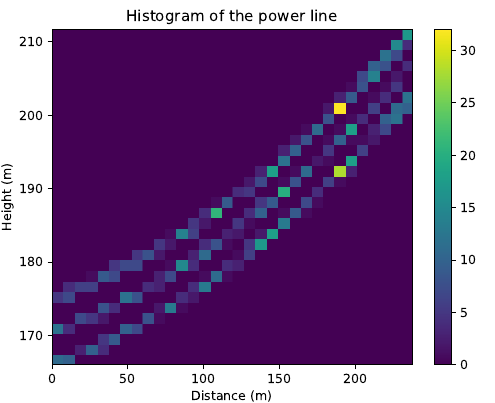
Figure 4. Raw histogram of a power line with three conductors placed in the same vertical plane. The colour bar in the histogram indicates the number of points per bin.